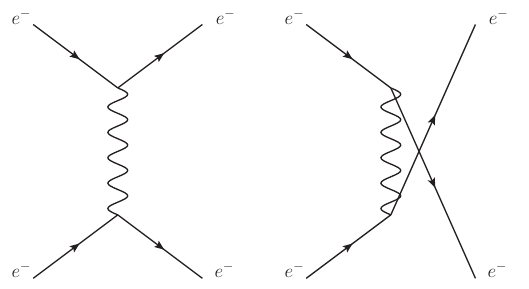
Figure 2: Feynman diagrams for Møller scattering, e − e − → e − e − , in the t (left) and u (right)